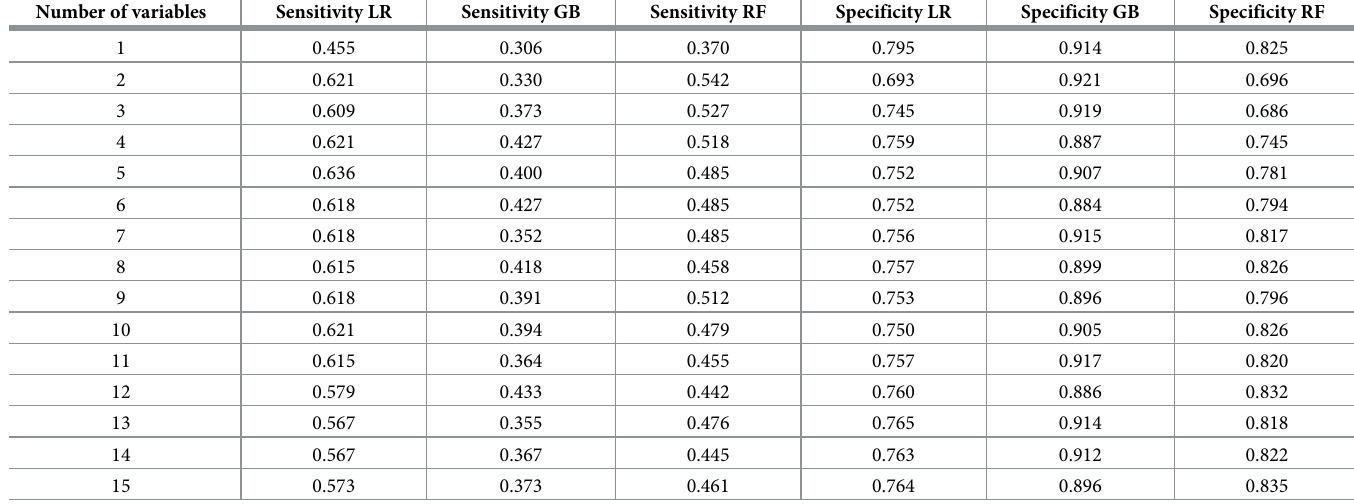
Table 5. Sensitivity and specificity values as a function of the number of variables for predicting revision ESS. We selected variables using the sequential forward selec- tion (SFS) method. Three models were used and the classifiers in these models were the logistic regression (LR), gradient boosting (GB) and random forest (RF) for pre- dicting revision